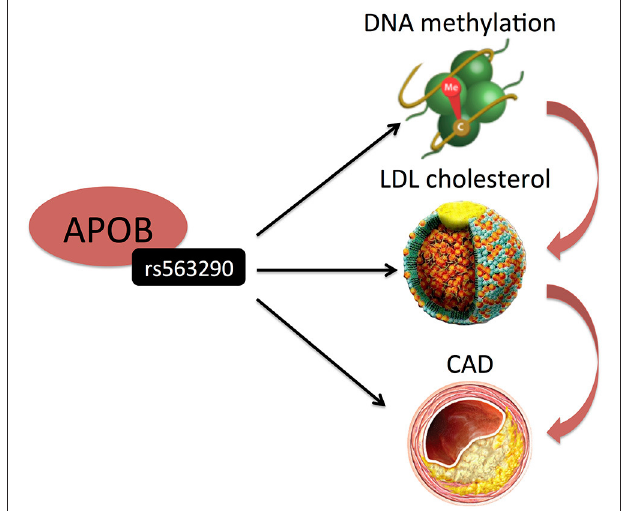
FIGURE 3 | Hedman et al. (27) identified SNP (rs515135) in an intron of APOB to be associated with LDL-C. Its proxy was also associated with CAD. Interestingly, this SNP represents a cis-meQTL. Black arrows indicate association findings. Red arrows indicate the presumed functional cascade leading to CAD.